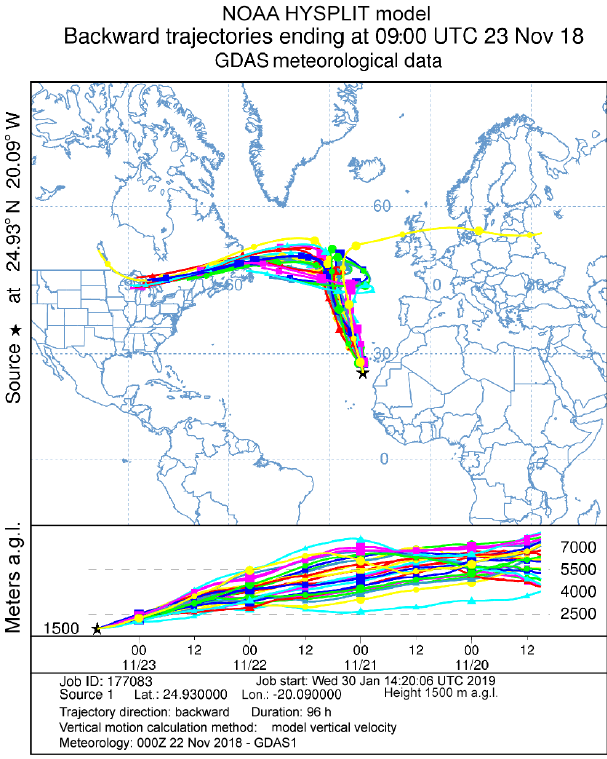
Figure 11. The 4d HYSPLIT backward trajectory ensemble arriv- ing at 1500m height above RV Polarstern (black star, 18.41 ◦ S, 32.93 ◦ W) on 23 November 2018 at